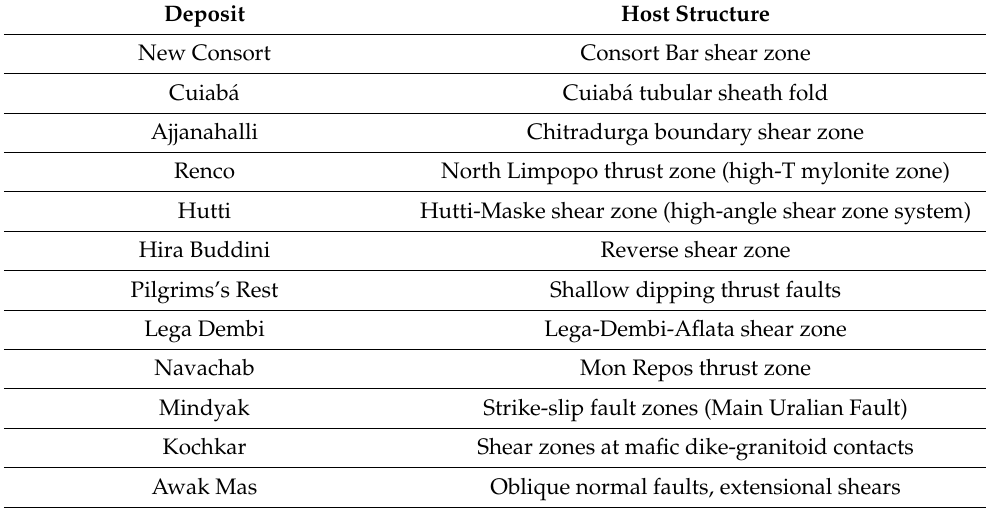
Table 2. Mineralization controlling structures.